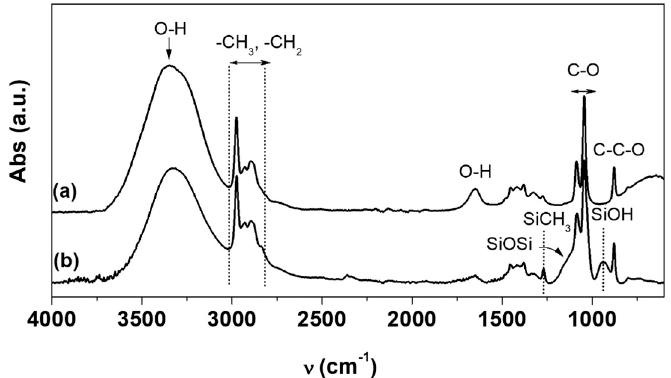
Figure 2. FTIR-ATR spectra of ( a ) EtOH/H 2 O with ZrO 2 and ( b ) silane solution ((T 1 M 2 ) 1 E 3 W 3 ).